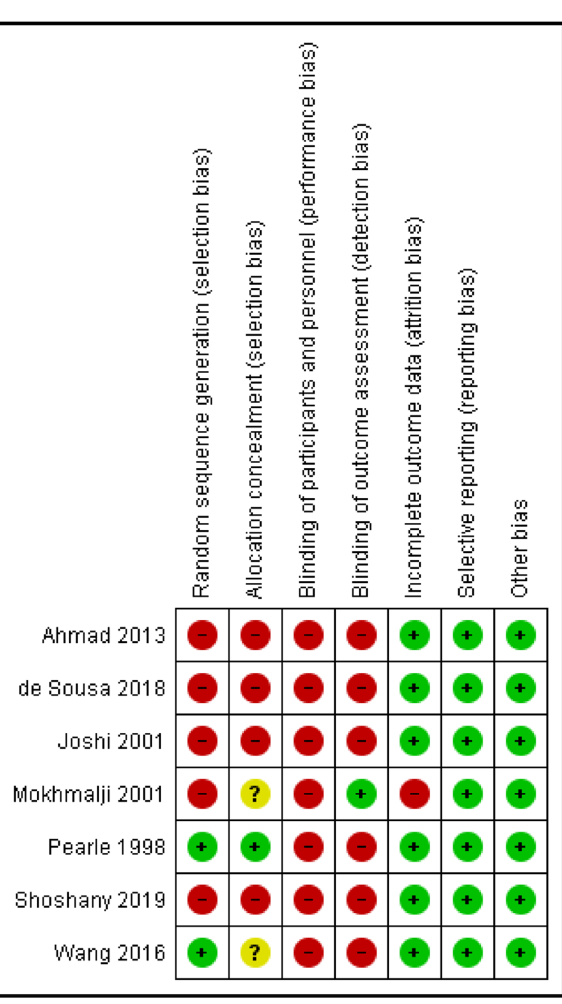
Figure 3. Risk of bias summary: review authors’ judgements about each risk of bias item for each included study.